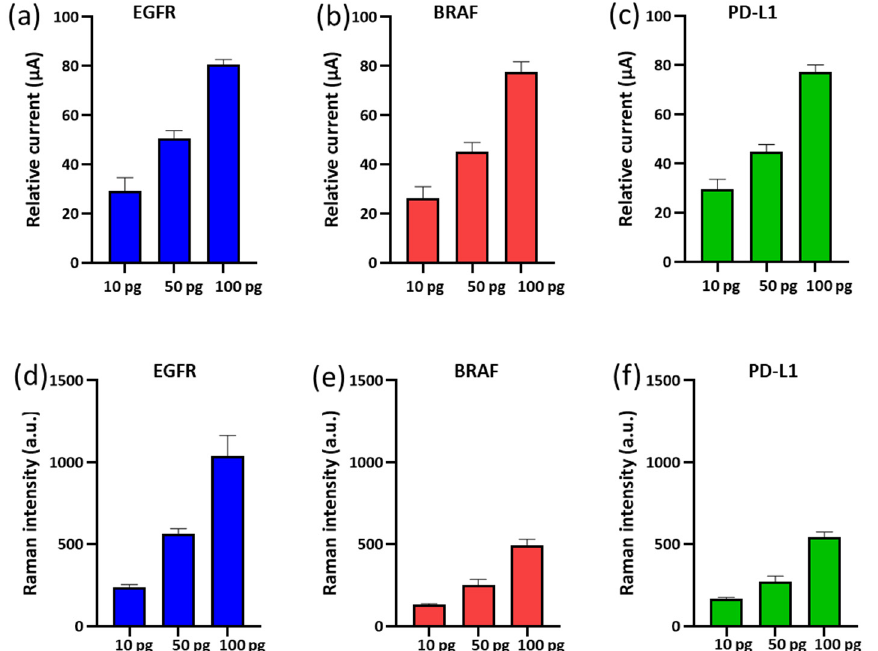
Figure 3. Sensitivity for individual detection of circulating proteins. DPV and SERS measurements of EGFR, BRAF and PDL-1 proteins for three different amounts: 10 pg, 50 pg and 100 pg (1 ng/mL, 5 ng/mL and 10 ng/mL, respectively). ( a – c ) relative DPV current reduction as a function of increase protein amount from 10–100 ng and ( d – f ) corresponding average Raman intensities. (n = 3) The Raman signal peak positions for measuring EGFR, BRAF and PDL-1 are 1335 cm − 1 , 1080 cm − 1 and 1376 cm − 1 , respectively. The error bars represent the standard deviation from three replicate runs.